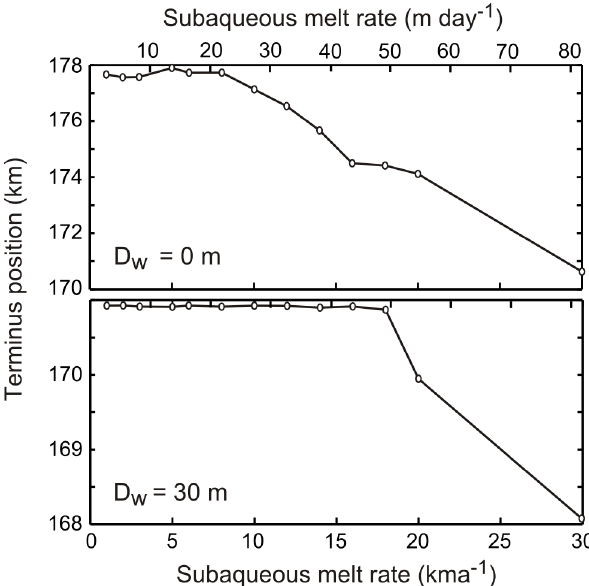
Fig. 6. Terminus location after a one year model run, forced with varying rates of submarine melt. (top) No water in crevasses. (bot- tom) Seasonally varying cwd with 0m in winter and 30m in sum-